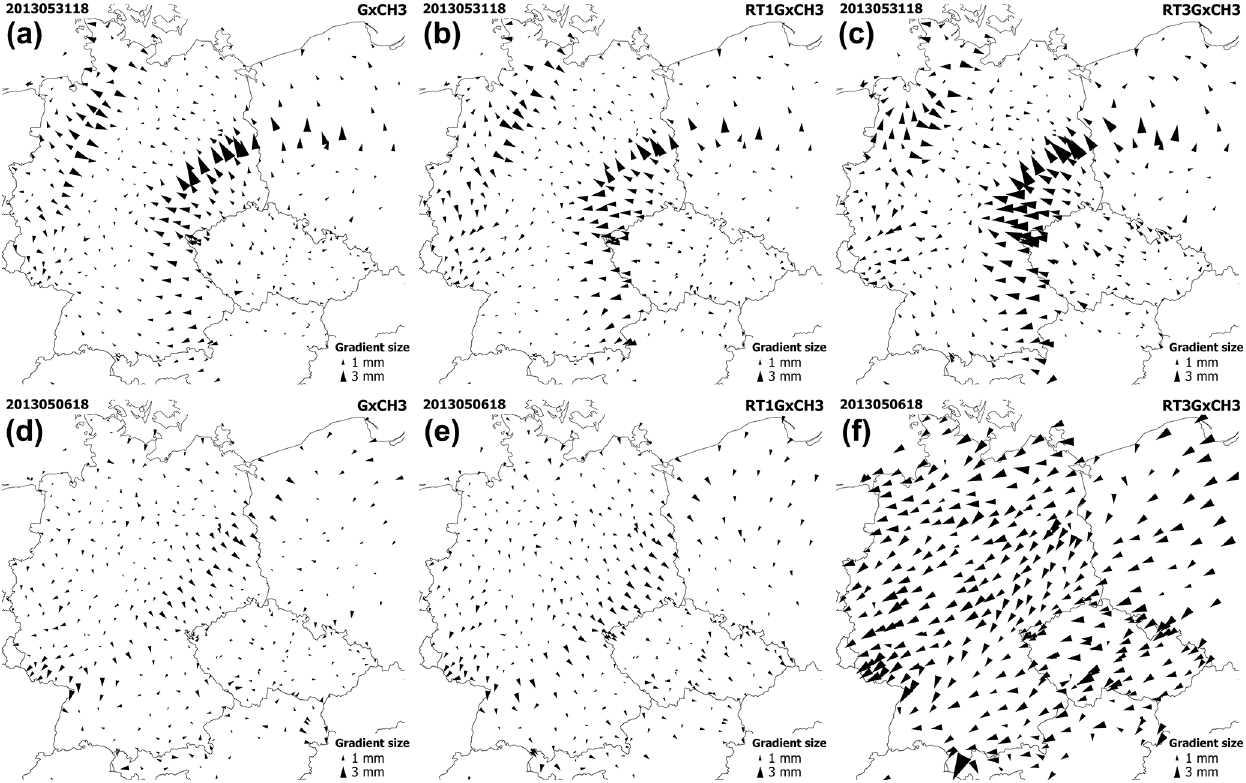
Figure 4. Tropospheric gradient maps from the GNSS GxCH3 solution (a, d) , GNSS RT1GxCH3 solution (b, e) and GNSS RT3GxCH3 solution (c, f) on 31 May 2013, 18:00UTC (a, b, c) and on 6 May 2013, 18:00UTC (d, e, f) .